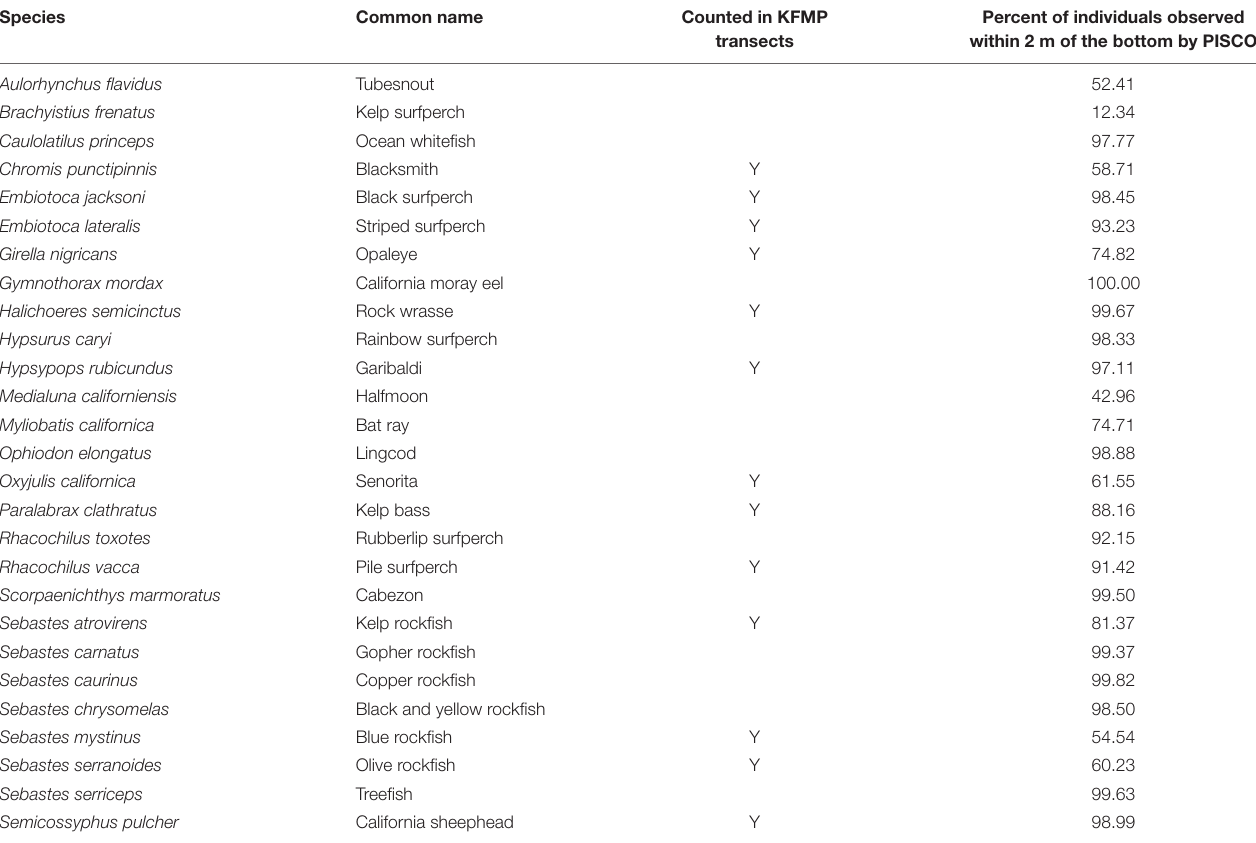
TABLE 1 | List of 35 species included in at least 10 KFMP roving diver-PISCO paired samples. The species also counted on KFMP transects are noted.